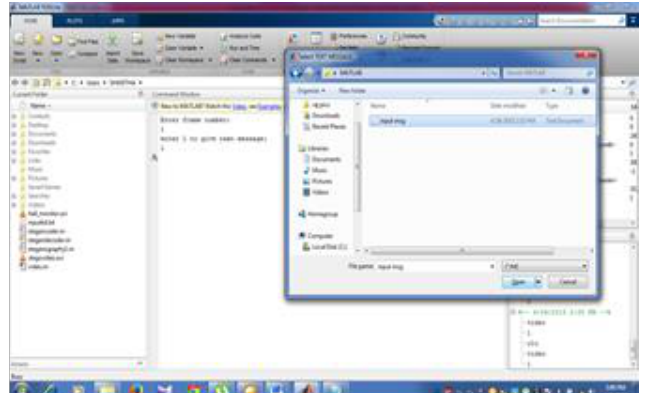
Figure. 10 Selecting Text file